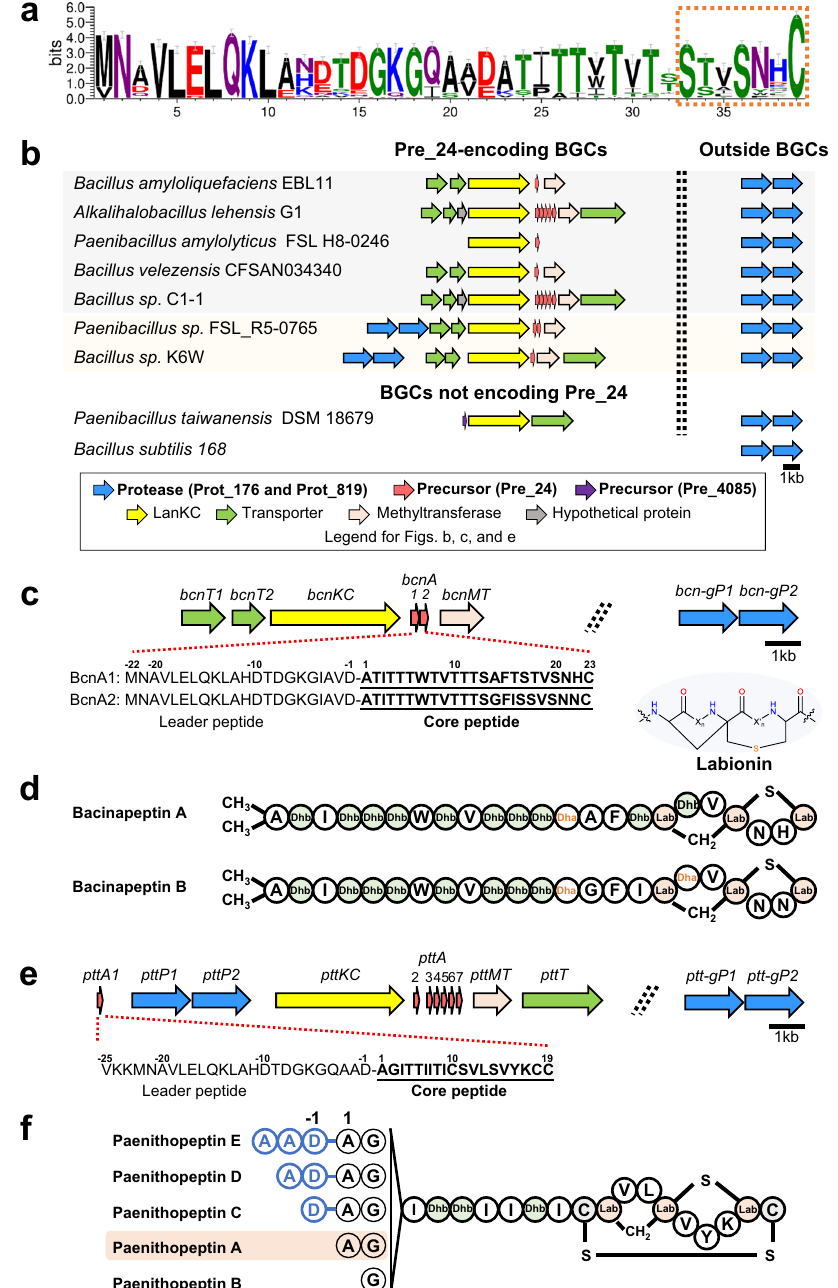
Fig. 3 Discovery of a family of previously unknown lanthipeptide proteases linked to the production of previously unreported class III lanthipeptides. a Sequence logo of Pre_24. Sequence alignments were trimmed by trimAl to remove gap-rich regions before drawing logo. The putative core peptides contain only one S-(X) 2 -S-(X) 2-5 -C motif (X stands for random amino acid) as opposed to two or three such motifs commonly seen in previously known class III lanthipeptides. Error bars indicate sample correction, and the total height of the error bar is twice this correction. b Representative class III lanthipeptide BGCs encoding Pre_24, showing distribution of a pair of protease-encoding genes, prot_176 and prot_819 , outside of the BGCs and an extra pair in a minority of the BGCs. In addition, a pair of prot_176 and prot_819 is also present in the genomes of many strains that do not harbor